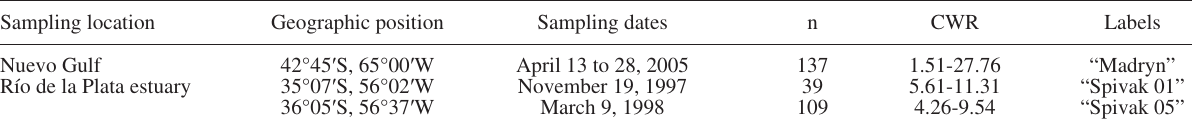
Table 1. – Sample composition. n: sample size and CWR: carapace width range (linear measurement in mm between the fourth lateral teeth ). Sampling